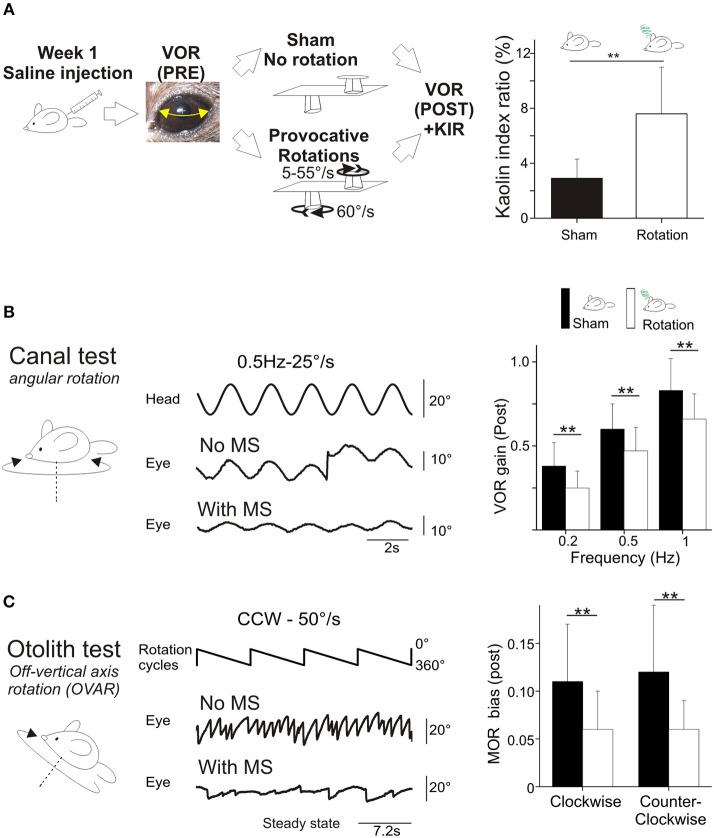
(A) Rotation induces motion sickness. Left, scheme of the protocol designed for intra-individual comparison. Animals received saline injection and VOR was tested before and after a sham experiment and a provocative double-rotation. Right, Pica behavior quantified as a Kaolin Index Ratio was quantified before and after rotation. (B) Motion sickness reduces angular horizontal vestibulo-ocular reflex. Left panel, raw traces of the eye movement observed during sinusoidal rotation of the turntable after the Sham or provocative rotation session. Right panel, intra-individual comparison of the VOR gain measured with or without MS. (C) Motion sickness reduces the maculo-ocular reflex. Off-vertical axis rotation was performed at velocities of 50°/s. A sample of 4 over 10 cycles of 360° rotations at constant velocity are presented. Left, raw traces of the eye movements evoked with or without MS. Right, intra-individual comparison of the MOR gain measured with or without MS. In this and all figures, plots represent mean ± standard deviation. Asterisks indicate statistically significant differences with Holm-Bonferroni correction, *p < 0.05; **p < 0.01; ***p < 0.001 respectively. For table position up is left; for ease of reading, eye position is inverted (up is right).